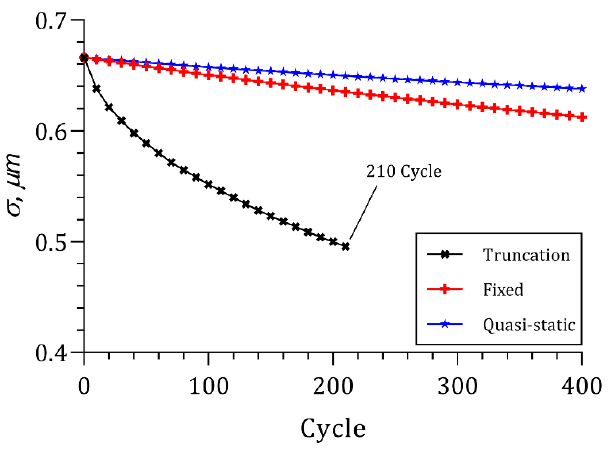
Figure 6. RMS roughness vs. wear cycle in the truncation model, deterministic fixed model, and deterministic quasi-static model.